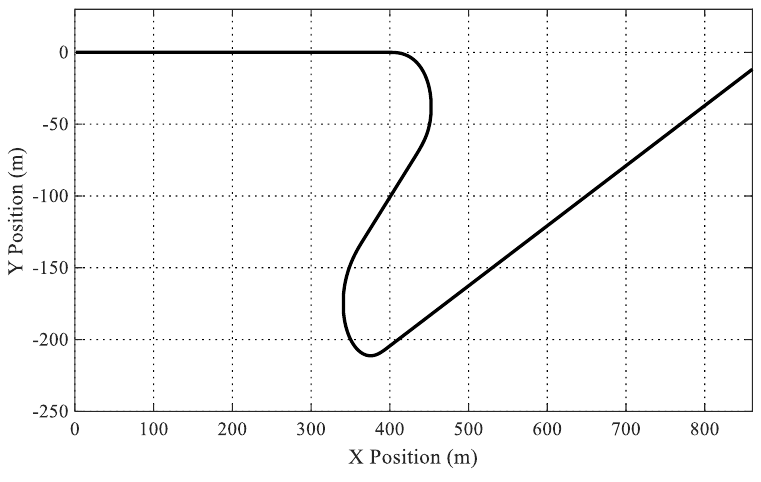
Figure 15. Position of the Vehicle for Scenario